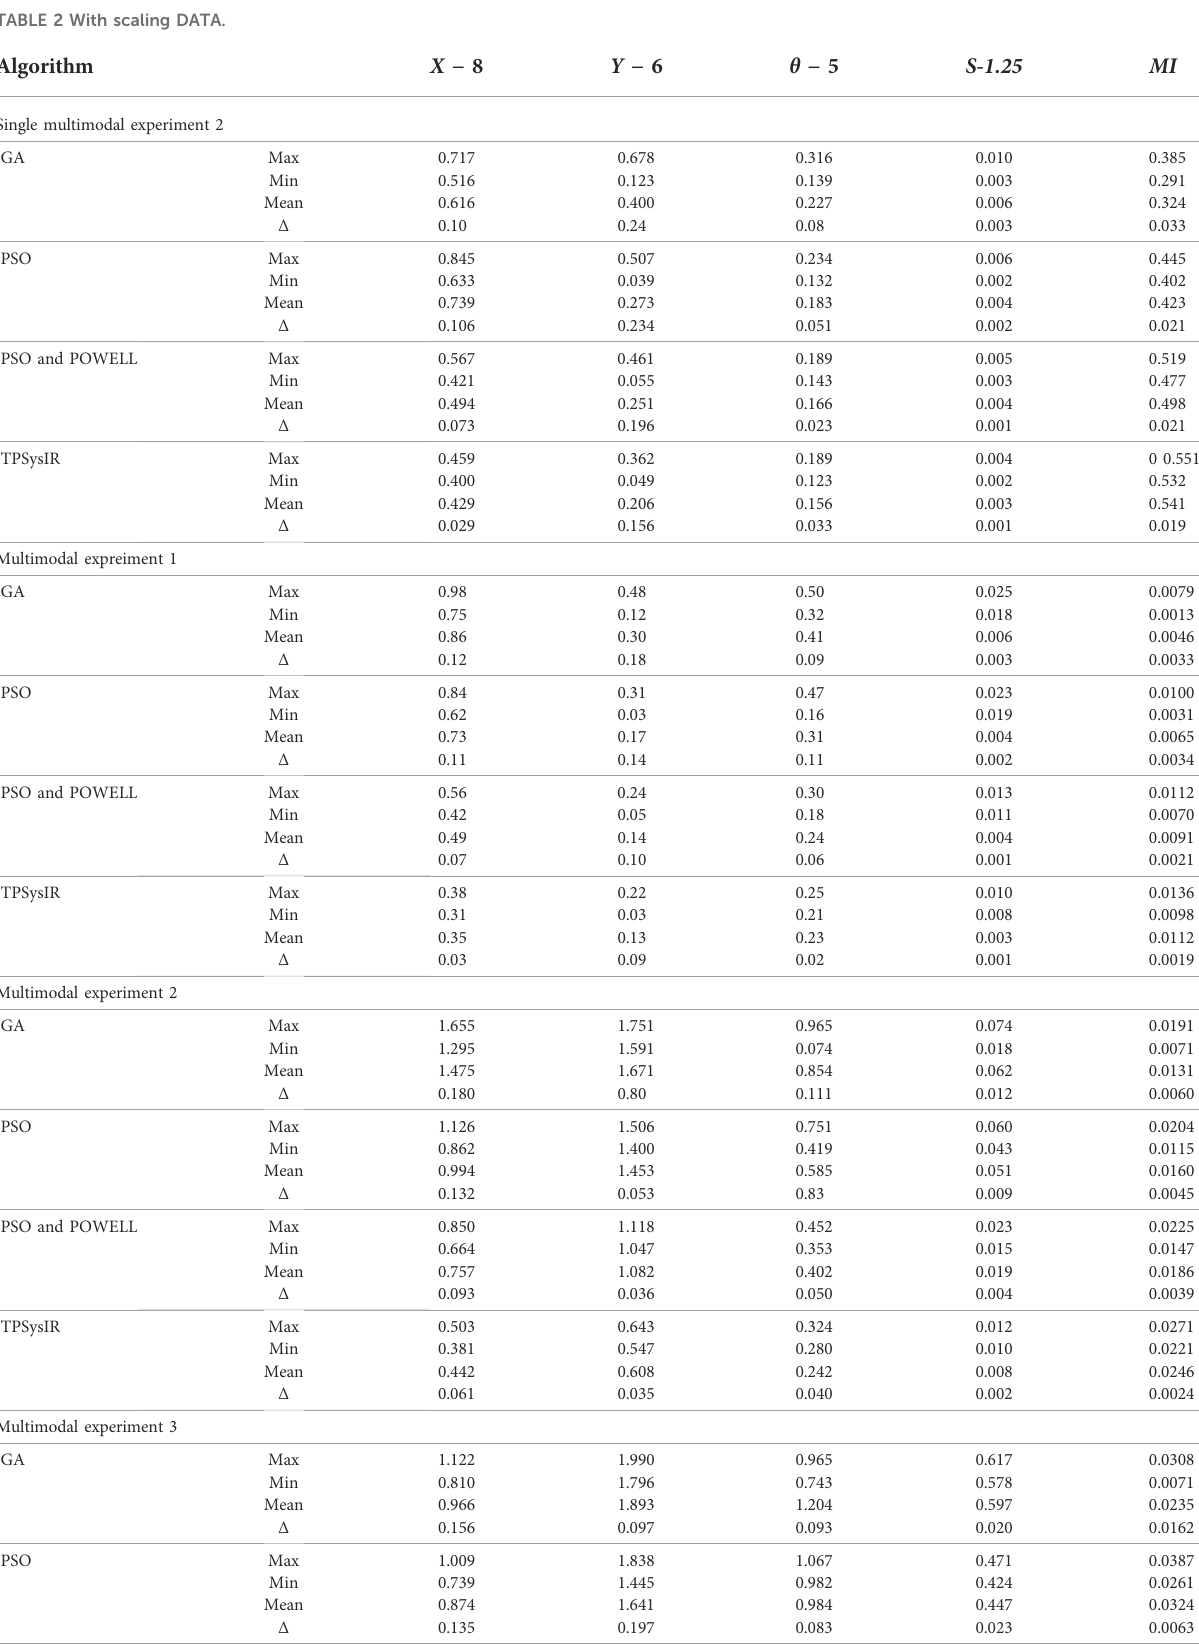
TABLE 2 With scaling